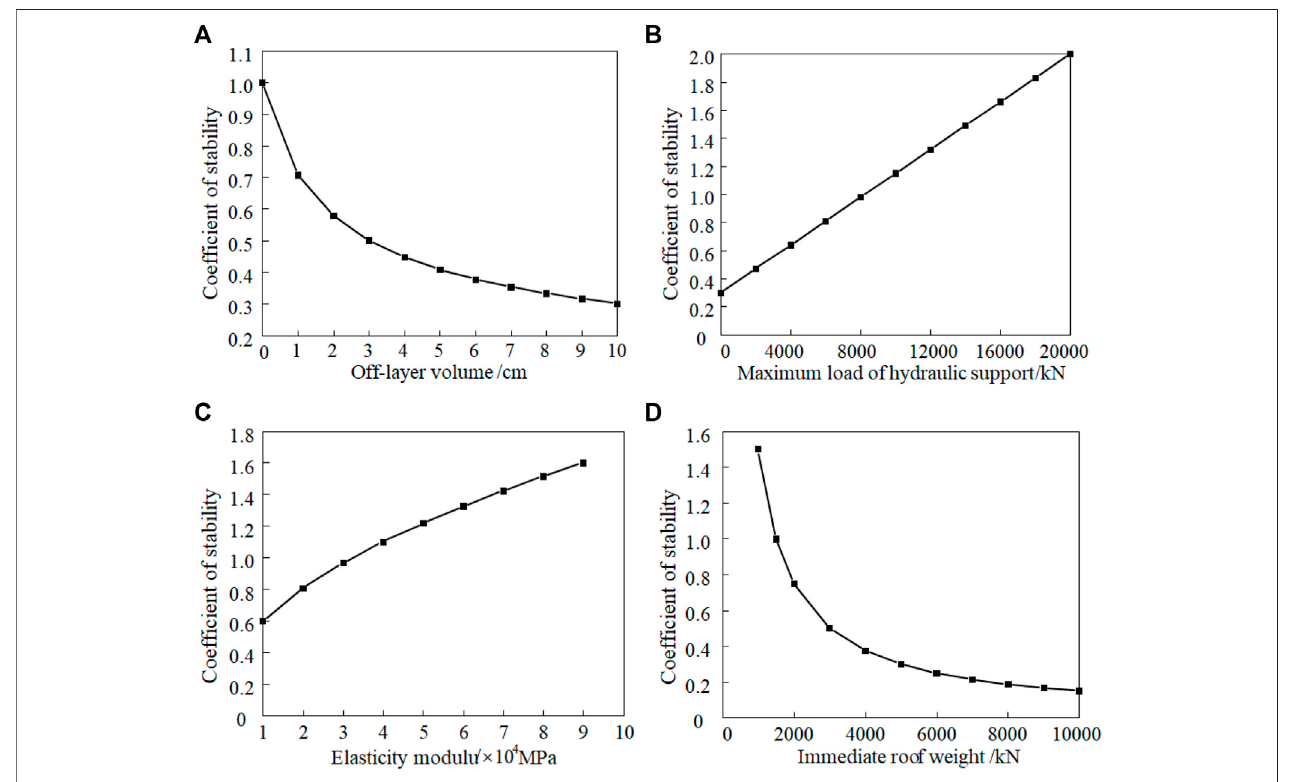
FIGURE 6 | Effect of stability coef fi cients for each